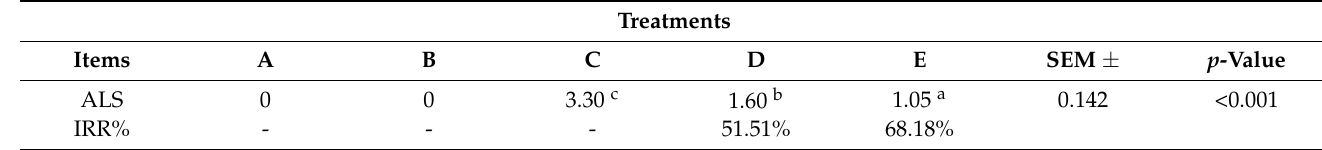
Table 4. GA decreased MG-induced gross air sac lesion scores in the broilers.